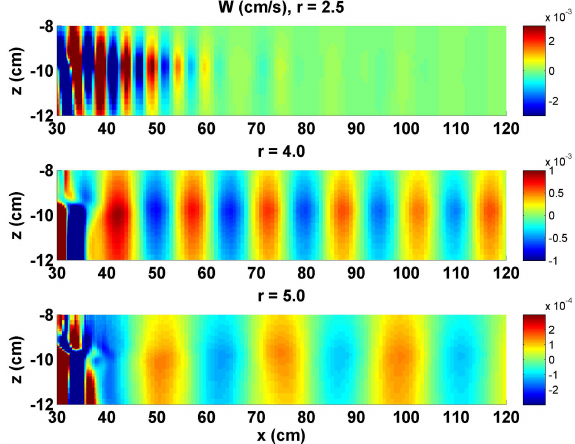
Figure 8. The trapped harmonic mode for r = 2 . 5 (top), r = 4 (mid- dle), and r = 5 (bottom). As r increases, the wavelength of the pre- ferred pycnocline mode increases and the amplitude